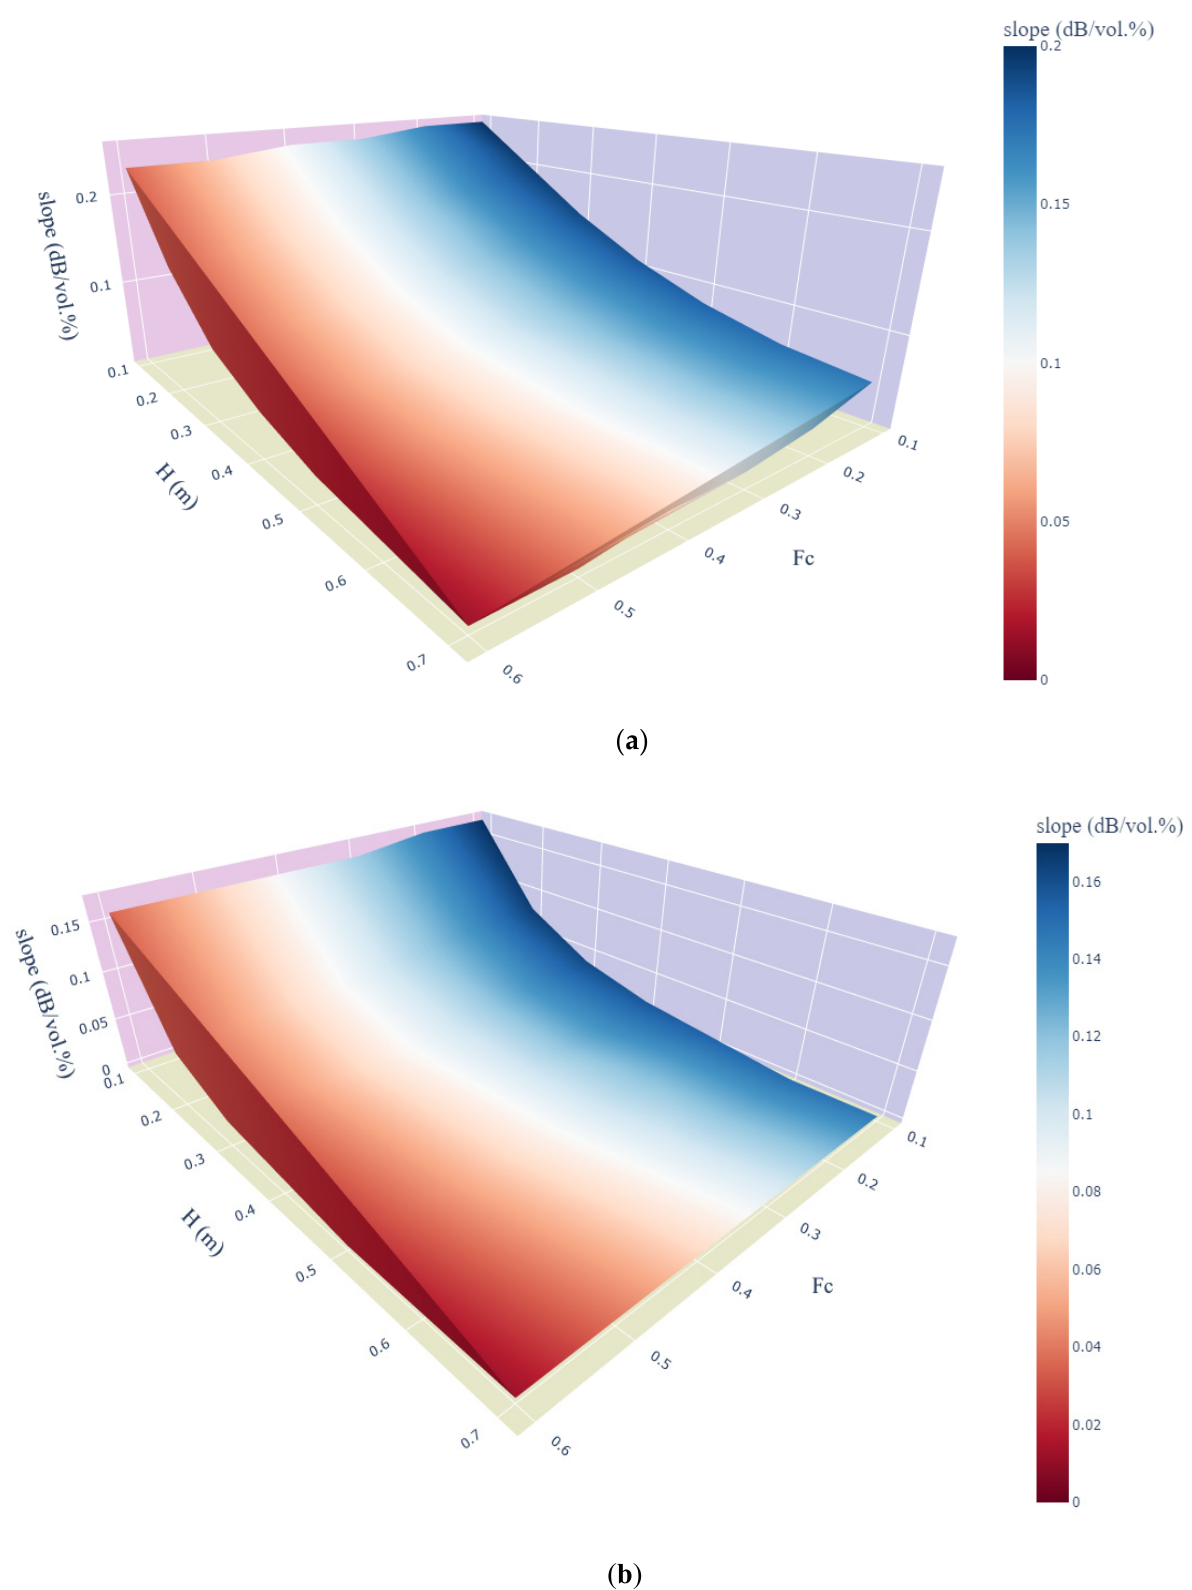
Figure 10. Three ‐ dimensional surface scatter plot of the modified WCM sensitivities to soil mois ‐ Figure 10. Three-dimensional surface scatter plot of the modified WCM sensitivities to soil moisture ture as a function of the pepper vegetation height and cover fraction using ( a ) L ‐ HH and ( b ) C ‐ VV as a function of the pepper vegetation height and cover fraction using ( a ) L-HH and ( b ) C-VV data.